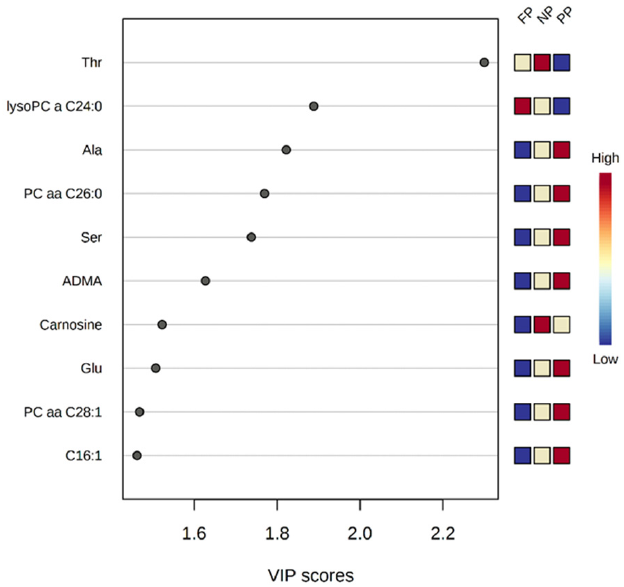
Figure 4. Top 10 metabolites (VIP scores) of calves at 30 days of age associated to the different prenatal treatments (NP, PP, and FP).